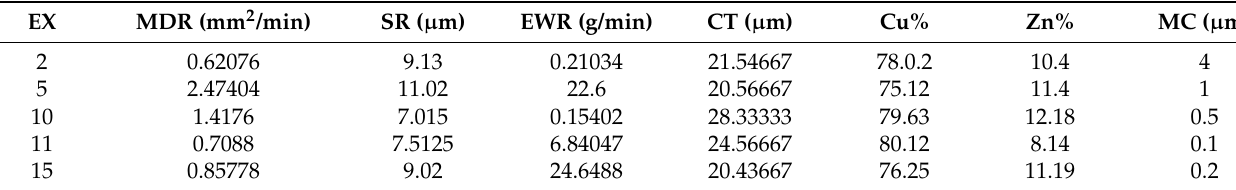
Table 7. Experimental Data.